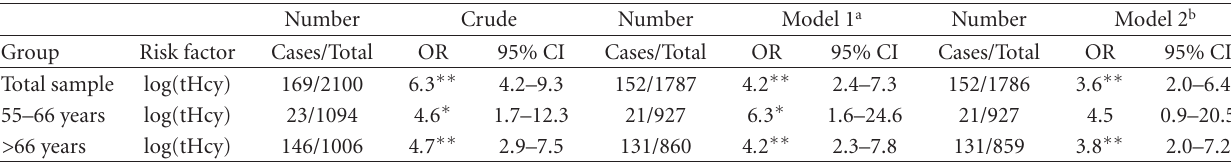
Table 2: Odds ratios (ORs) for risk of dementia associated with log-transformed levels of total homocysteine (tHcy).